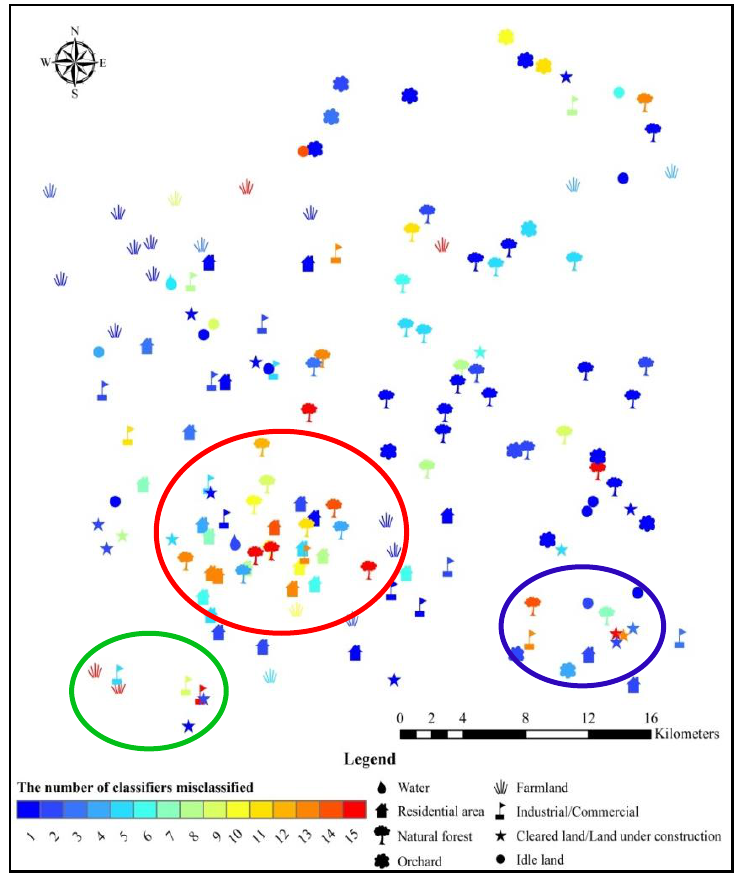
Figure 3. The distribution of misclassified test samples.